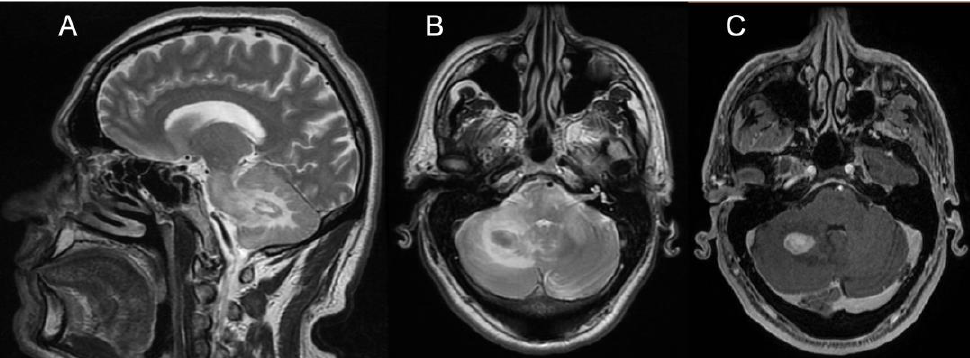
Figure 2. Panel showing brain MRI of Patient #2. ( A ) Sagittal T2-weighted scan showing one nodular lesion along with extensive hyperintensity of the white matter of the RCH, the ipsilateral MCP, and the pons. ( B ) Transverse T2-weighted scan (pons level) showing the same nodular hypointense lesion with hyperintensity of the white matter of the RCH, both MCPs and the pons. ( C ) Transverse T1-weighted scan (pons level) showing marked, homogeneous contrast enhancement of the RCH nodular lesion. Abbreviations: RCH: right cerebellar hemisphere; MCP: middle cerebellar peduncle.